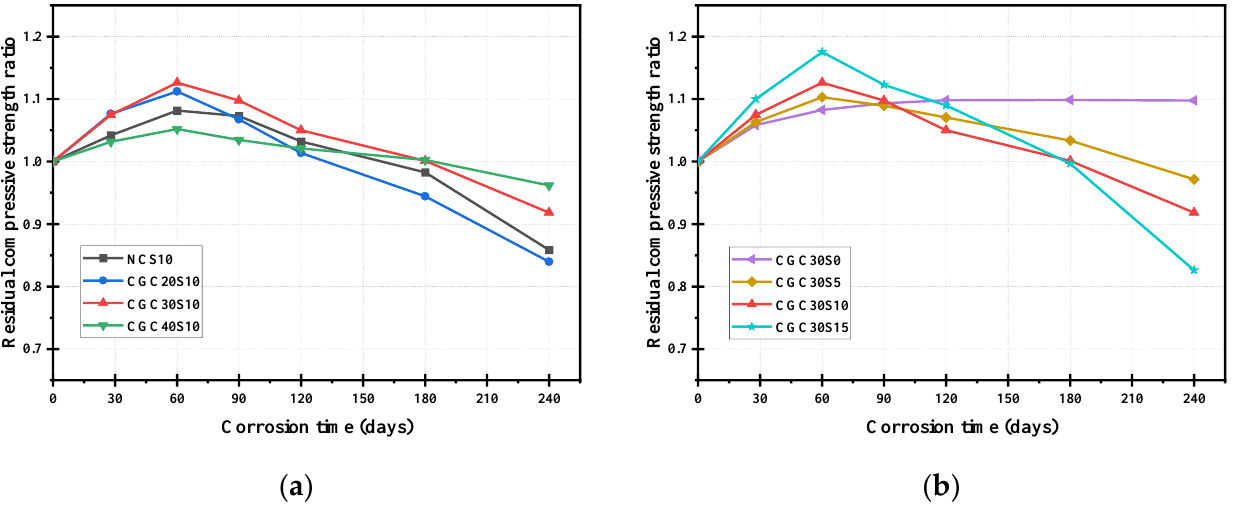
Figure 7. Residual compressive strength ratio of specimens at different corrosion times under sulfate attack: ( a ) different concrete; ( b ) different sulfate concentration.